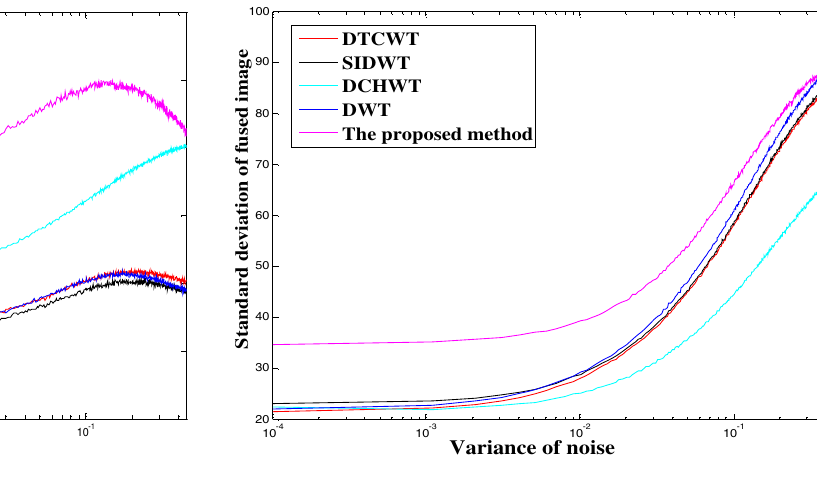
(c) Plot of EN fusion metric against zero mean Gaussian noise (d) Plot of STD fusion metric against zero mean Gaussian noise